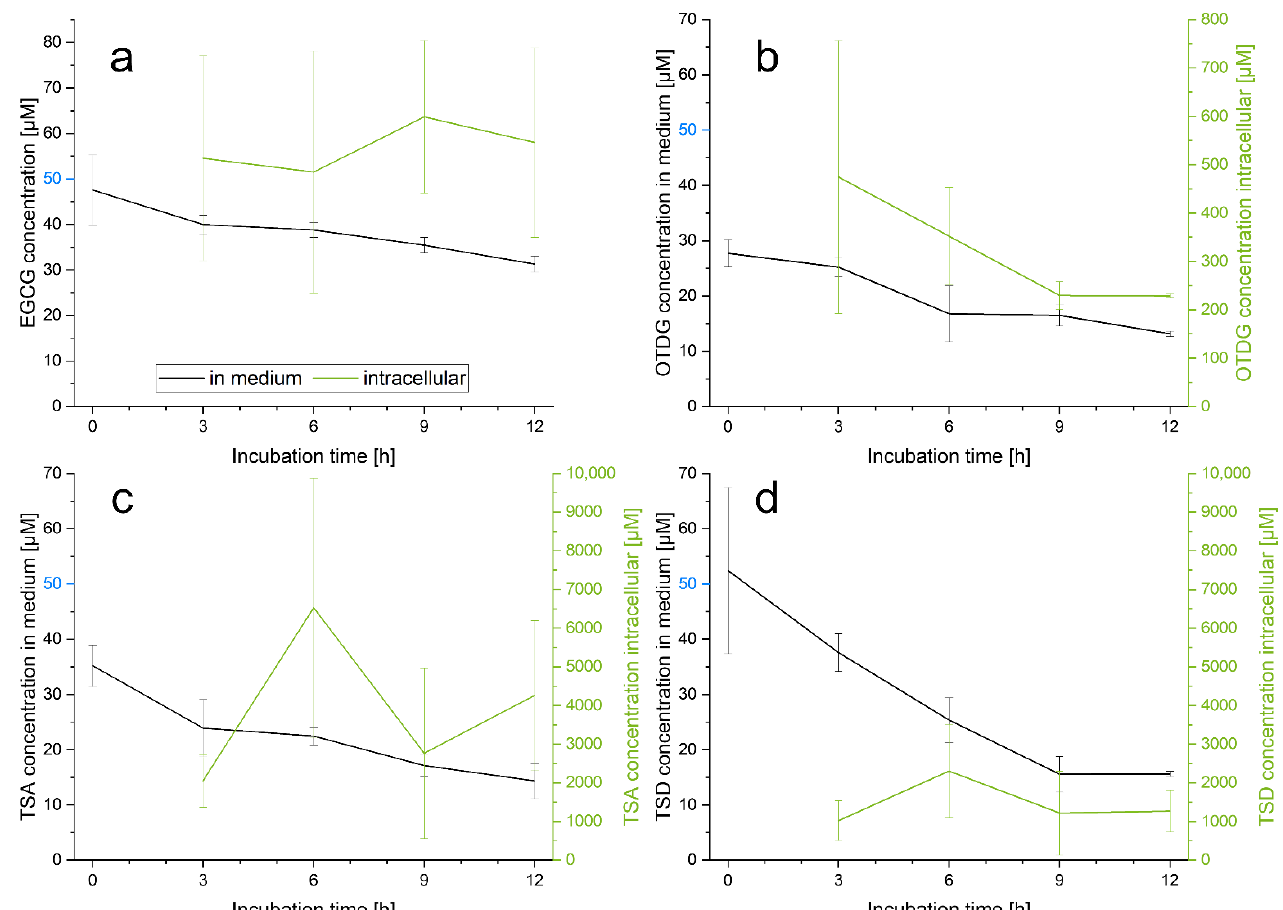
Figure 3. Cellular uptake assessment in HepG2 cells under stabilized conditions (see Section 2.4) quantified in medium and intracellularly as cell lysate via HPLC-MS/MS, n = 3, after incubation (marked in blue) of ( a ) EGCG, 50 µM; ( b ) OTDG, 50 µM; ( c ) TSA, 50 µM; ( d ) TSD, 50 µM.